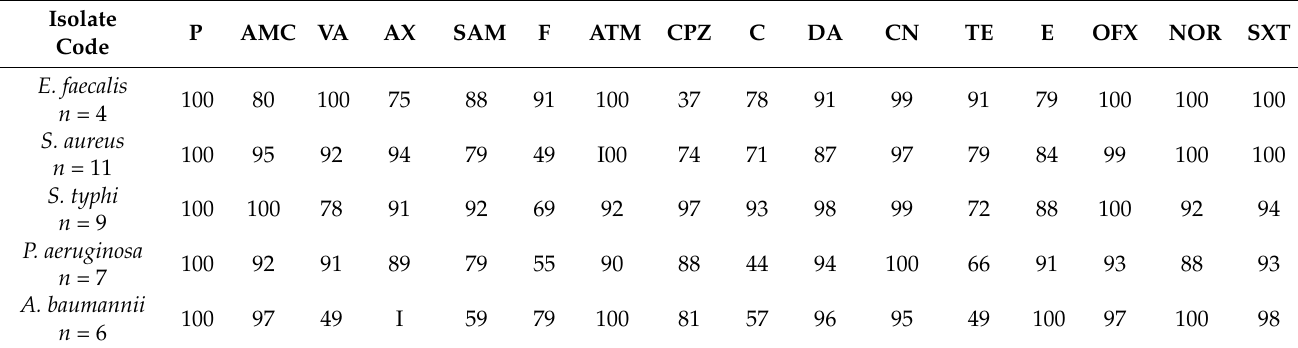
Table 1. The antibiotic susceptibility test for all studied isolates.